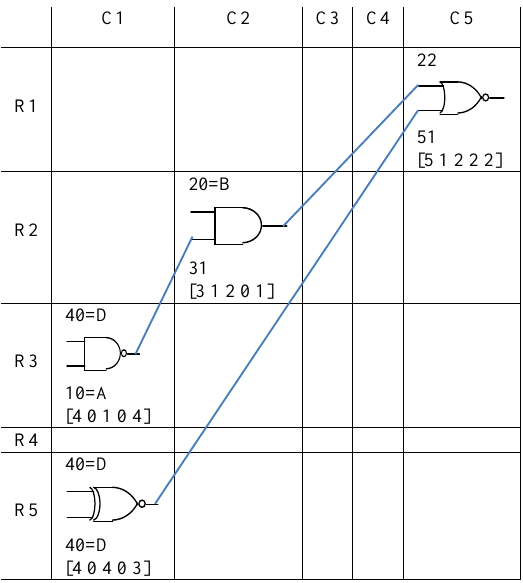
Figure 1. A typical array of 5 candidate solutions .